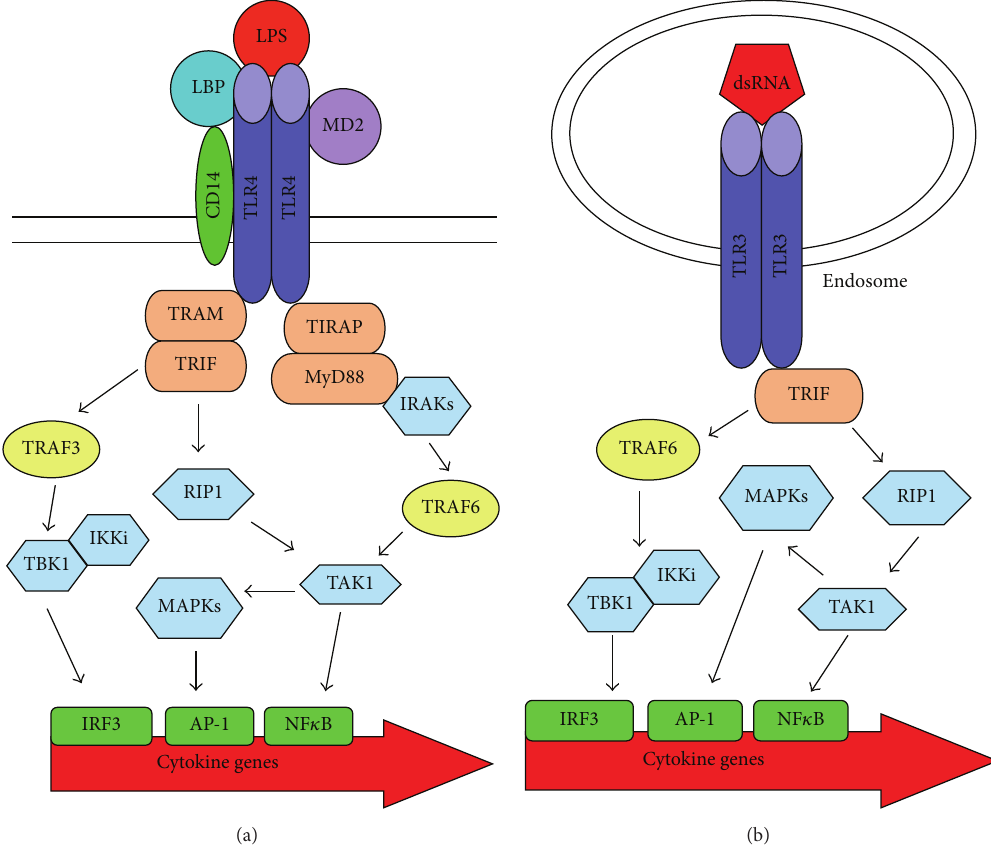
Figure 2: TLR signal transduction pathways. (a) Signaling through TLR4 by bacterial LPS. TLR4 forms a complex with LBP, MD2, and CD14. When LPS binds TLR4, two adaptor complexes are recruited. The MyD88-dependent pathway activates IRAKs eventually leading to activation of TAK1 that leads to activation of transcription factor NF- 𝜅 B and stimulates the MAPK pathways for transcription factor AP-1 activity. The TRIF-dependent pathway occurs within endosomes and activates RIP1, also resulting in TAK1 activation. Through TRAF3, IKKi and TBK1 are activated leading to the activation of transfer transcription factor IRF-3. (b) Signal through TLR3 by nucleic acids occurs within endosomes. When the receptor is occupied, TLR3 alone binds TRIF without TRAM. RIP1 is activated leading to the same subsequent events as those during TLR4 signaling. TRIF also activates IKKi and TBK1 leading to transcription factor IRF-3 activation, but involves TRAF6, not TRAF3. TLR: Toll-like receptor; LPS: lipopolysaccharide; LBP: LPS-binding protein; MD2: myeloid differentiation-2 protein; MyD88: myeloid differentiation primary response 88; TIR: Toll/interleukin-1 receptor; TIRAP: TIR-containing adaptor protein; TRIF: TIR domain- containing adaptor-inducing interferon- 𝛽 ; TRAM: TRIF-related adaptor molecule; IL: interleukin; IRAK: IL-1R-associated kinases; TNF: tumor necrosis factor; TRAF: TNF receptor-associated factors; TBK1: TANK-binding kinase-1; MAPK: mitogen-activated protein